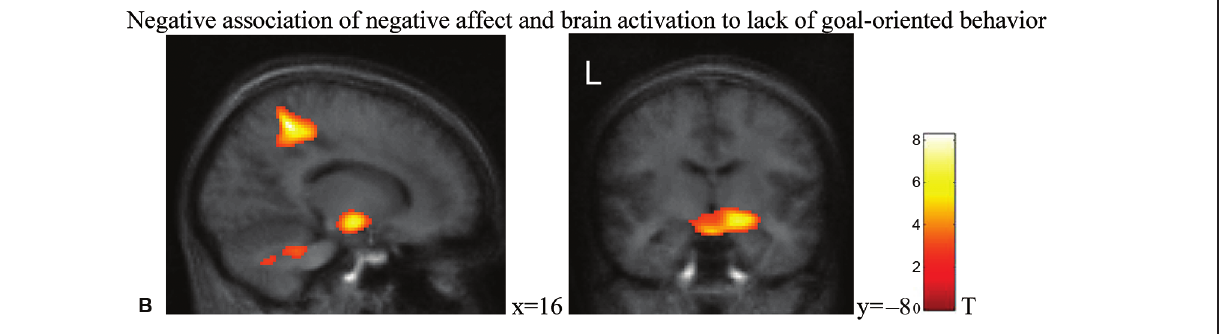
hippocampal responses were associated with NA ratings. Positive association of NA and brain activation to lack of goal-oriented behavior. Negative association of NA and brain activation to lack of goal-oriented